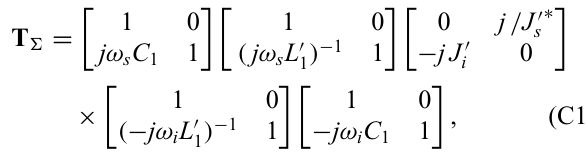
, right). (b) Equivalence between the P (ω ) = Y ( − ω ) i i i i